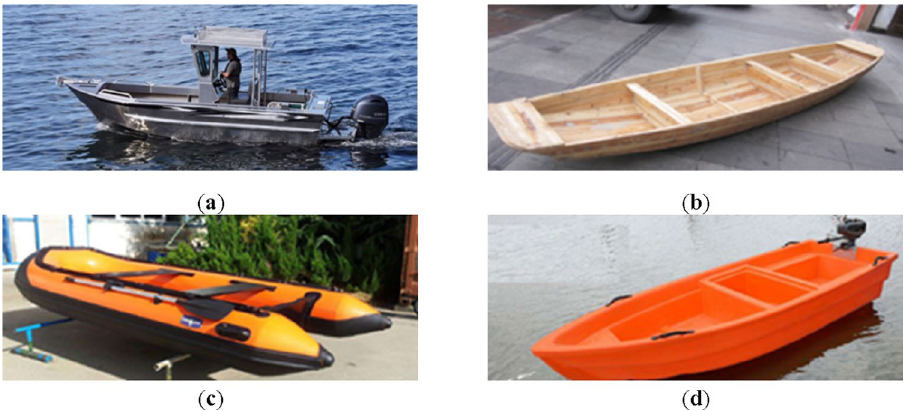
Figure 1. Types of four different types of small fishing vessels. ( a ) Small alloy fishing vessels, ( b ) wooden fishing vessels, ( c ) rubber inflatable fishing vessels, ( d ) PE plastic fishing